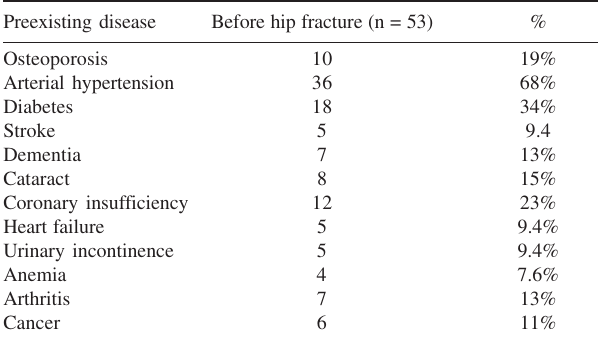
Table 2 - Distribution of patients according to place of fall Place of fall Number of subjects